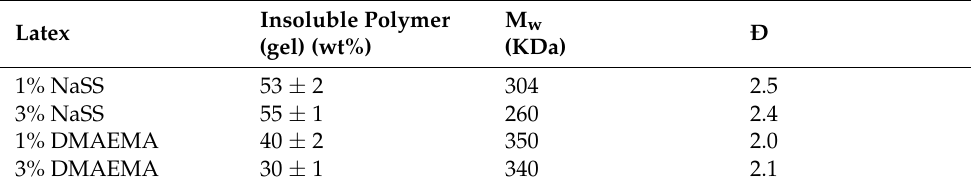
Table 3. Microstructure of the charged